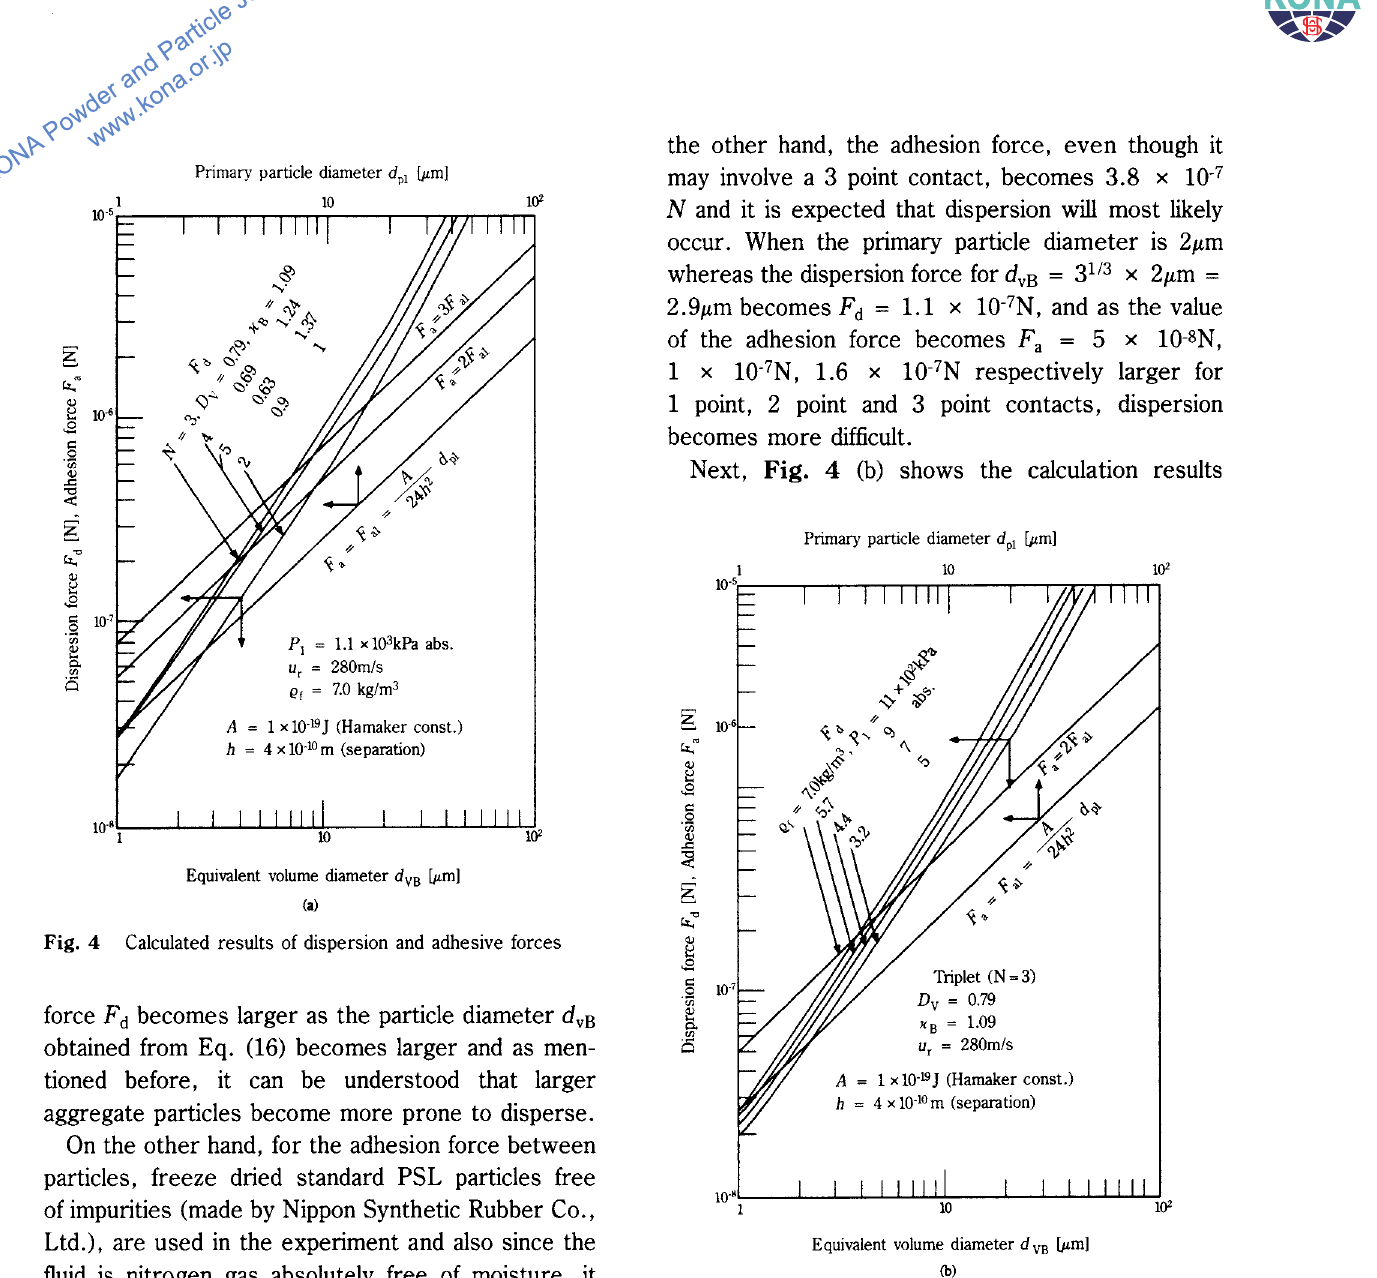
Fig. 4 Calculated results of dispersion and adhesive forces when triplets consisting of 3 primary particles dis perse into 1 and 2 particles. In this case, since aggre gate particles are limited to triplets, the dispersion force is determined only by the fluid resistance. As mentioned before, the figure shows that the dis e persion force is determined by the density f of the fluid when the fluid velocicty reaches critical velocity (280 m/s). From this figure also, it can be seen that primary 5,um triplets can disperse and that when the primary particle diameter is 2,um, disper sion becomes difficult. When Stokes drag force acts on particles with diameters of 2,um and 5,um, the dispersion force is proportional to the particles diameter but at